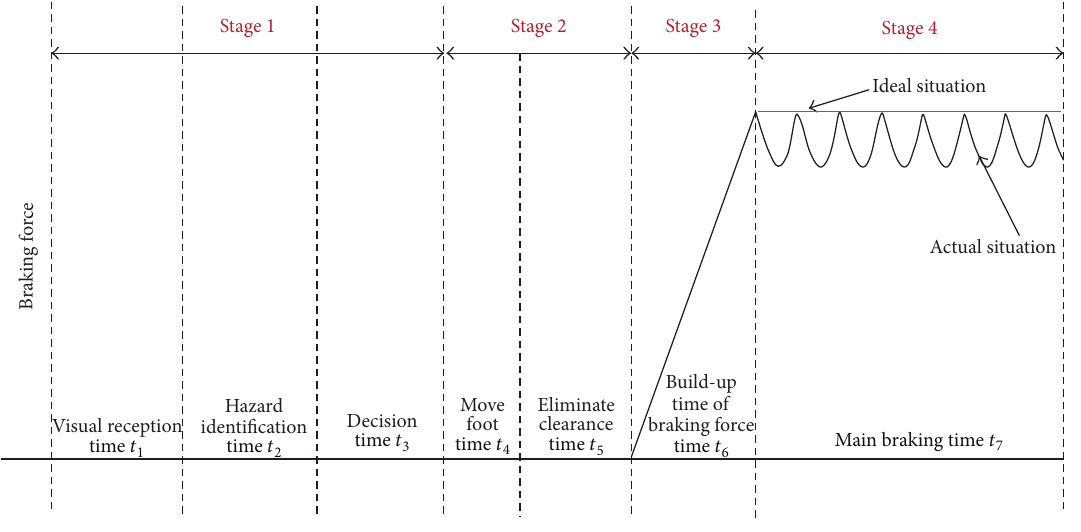
Figure 1: Braking process